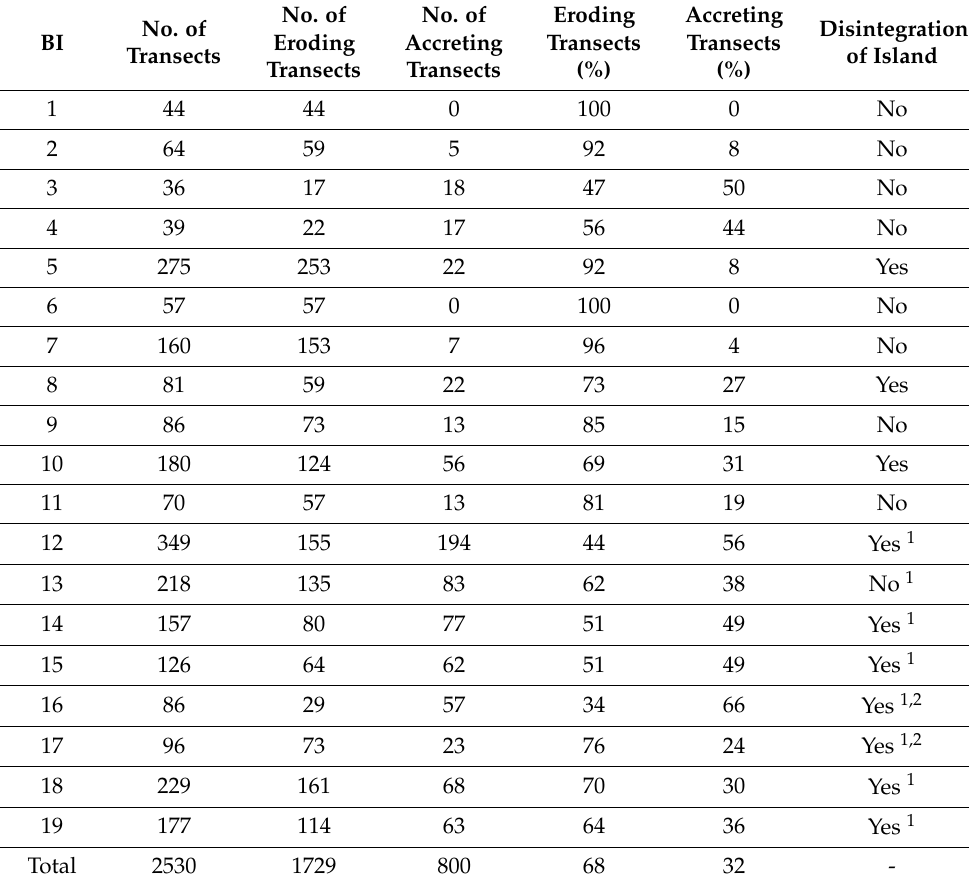
Table 3. Barrier island wise morphological changes with respect to the perimeter from 1989 to 2018 at all